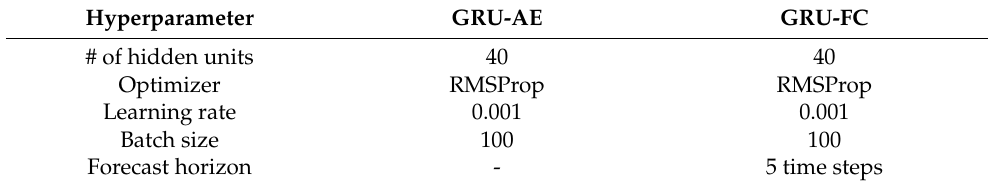
Table 3 lists the selected hyperparameters of the GRU-AE and GRU-FC models, which were derived from comprehensive training and validation runs. Table 3. Selected hyperparameters of the autoencoder (GRU-AE) and forecaster (GRU-FC) models.